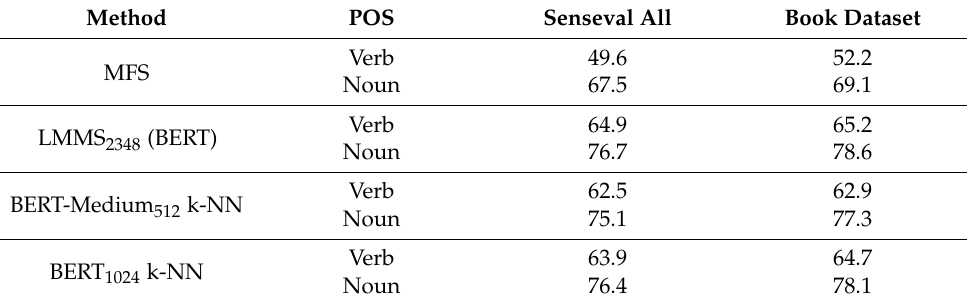
Table 4. WordNet sense disambiguation results (F1